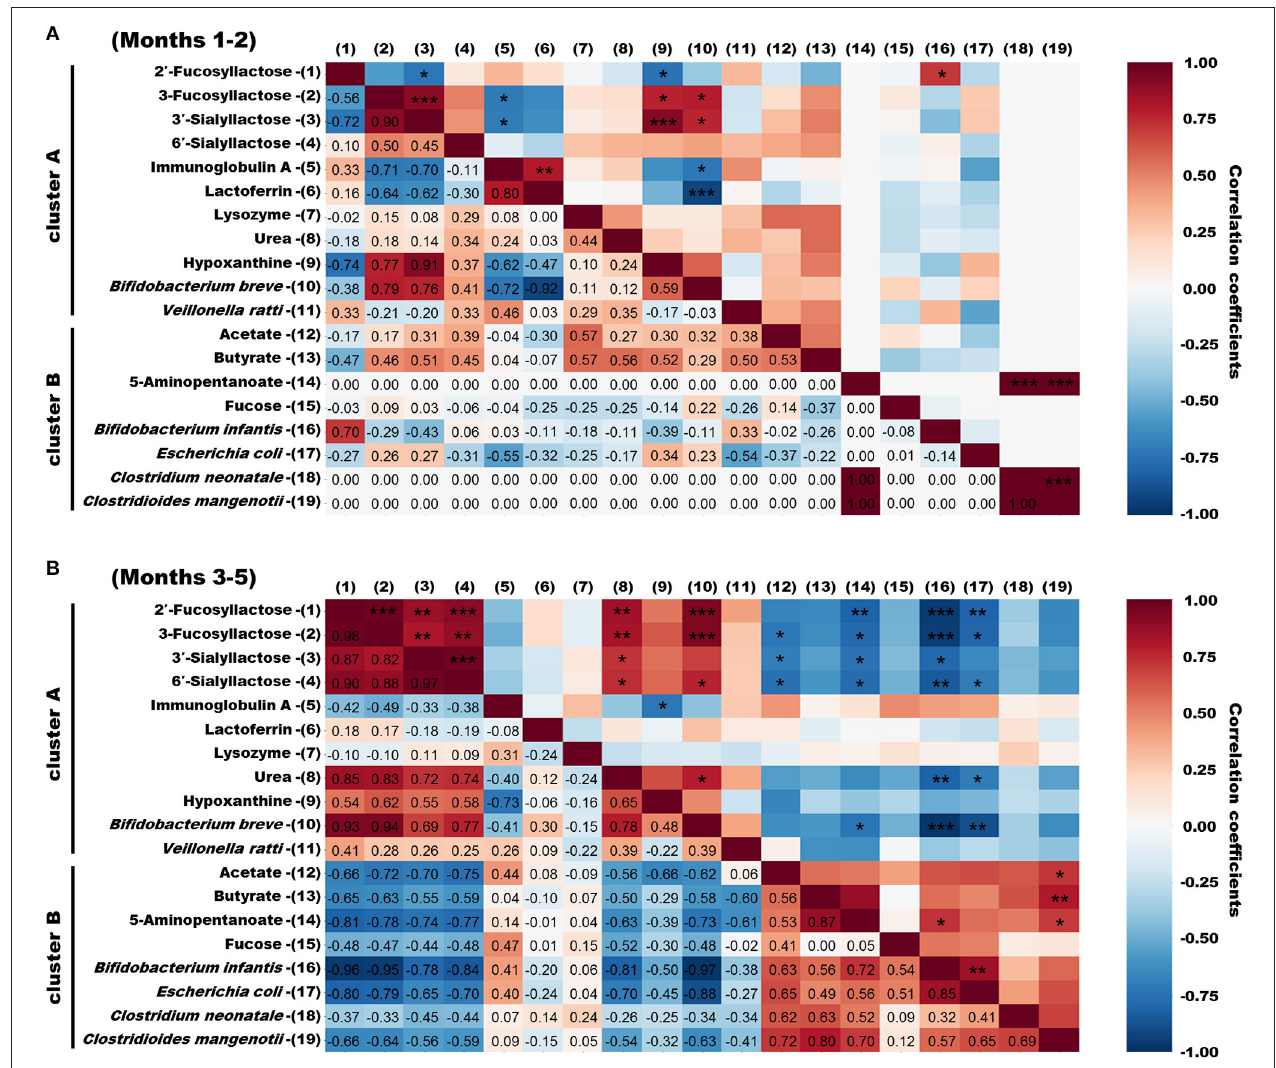
FIGURE 6 | Spearman correlation heatmaps of bioactive milk components, the infant gut microbiome, and fecal metabolites in infant feces. (A) Spearman rank correlation coefficients of bioactive milk components, bacterial species, and metabolites in infant feces at months 1–2 postpartum with high similarity categorized into clusters A and B. (B) Spearman rank correlation coefficients of bioactive milk components, bacterial species, and metabolites in infant feces at months 3–5 postpartum with high similarity categorized into clusters A and B. Spearman ρ values are shown in different colors and | ρ | values are shown as *0.7–0.8, **0.8–0.9, and *** > 0.9. mo,